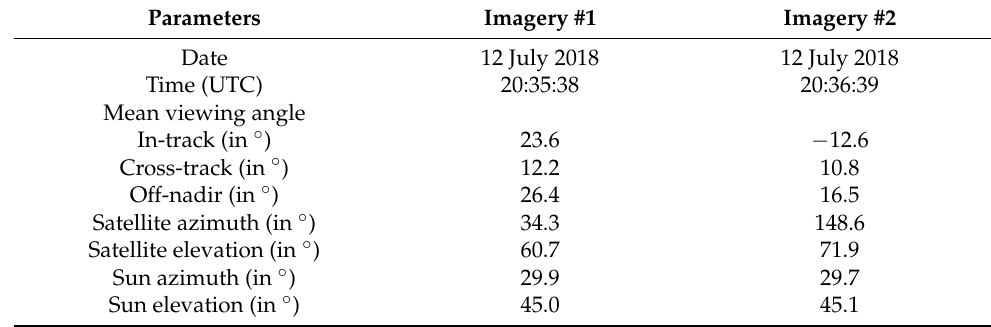
Table 2. WorldView-3 specifications related to the stereo-imagery acquisition over the study